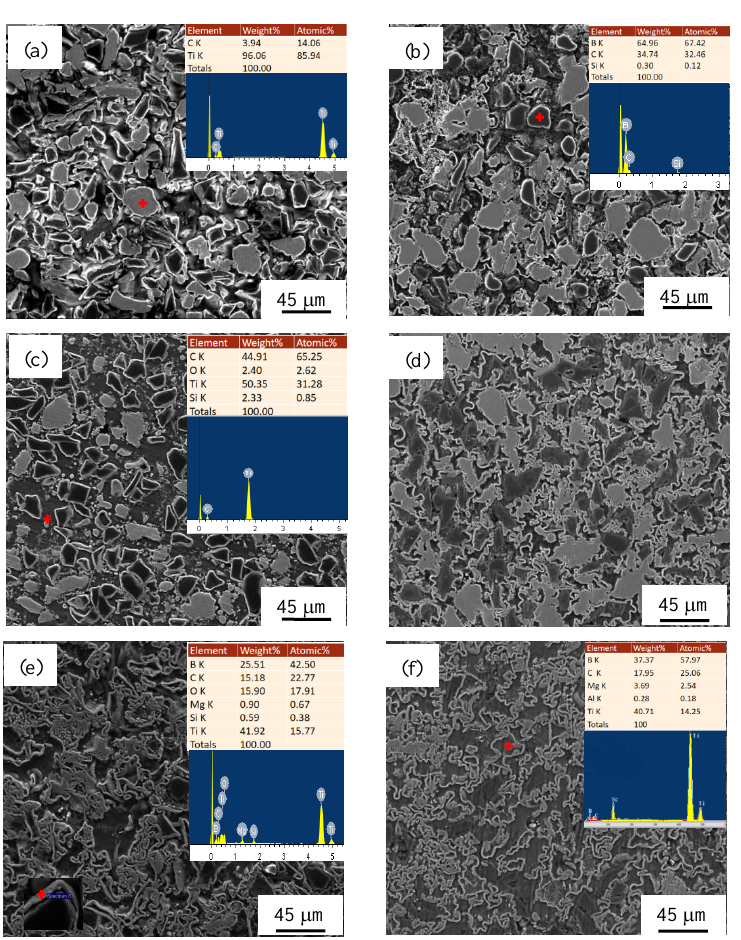
Figure 2. SEM images and EDS of (B 4 C+Ti)/Mg ( a , c , e ) and (B 4 C+Ti)/AZ91D ( b , d , f ) composites pre- pared for 30 min ( a , b ), 90 min ( c , d ) and 180 min ( e , f ). XRD spectra, identified by the experimental PXRD Database of the as-fabricated (B 4 C+Ti)/Mg and (B 4 C+Ti)/AZ91D composites, is displayed in Figure 3. As shown in Fig-